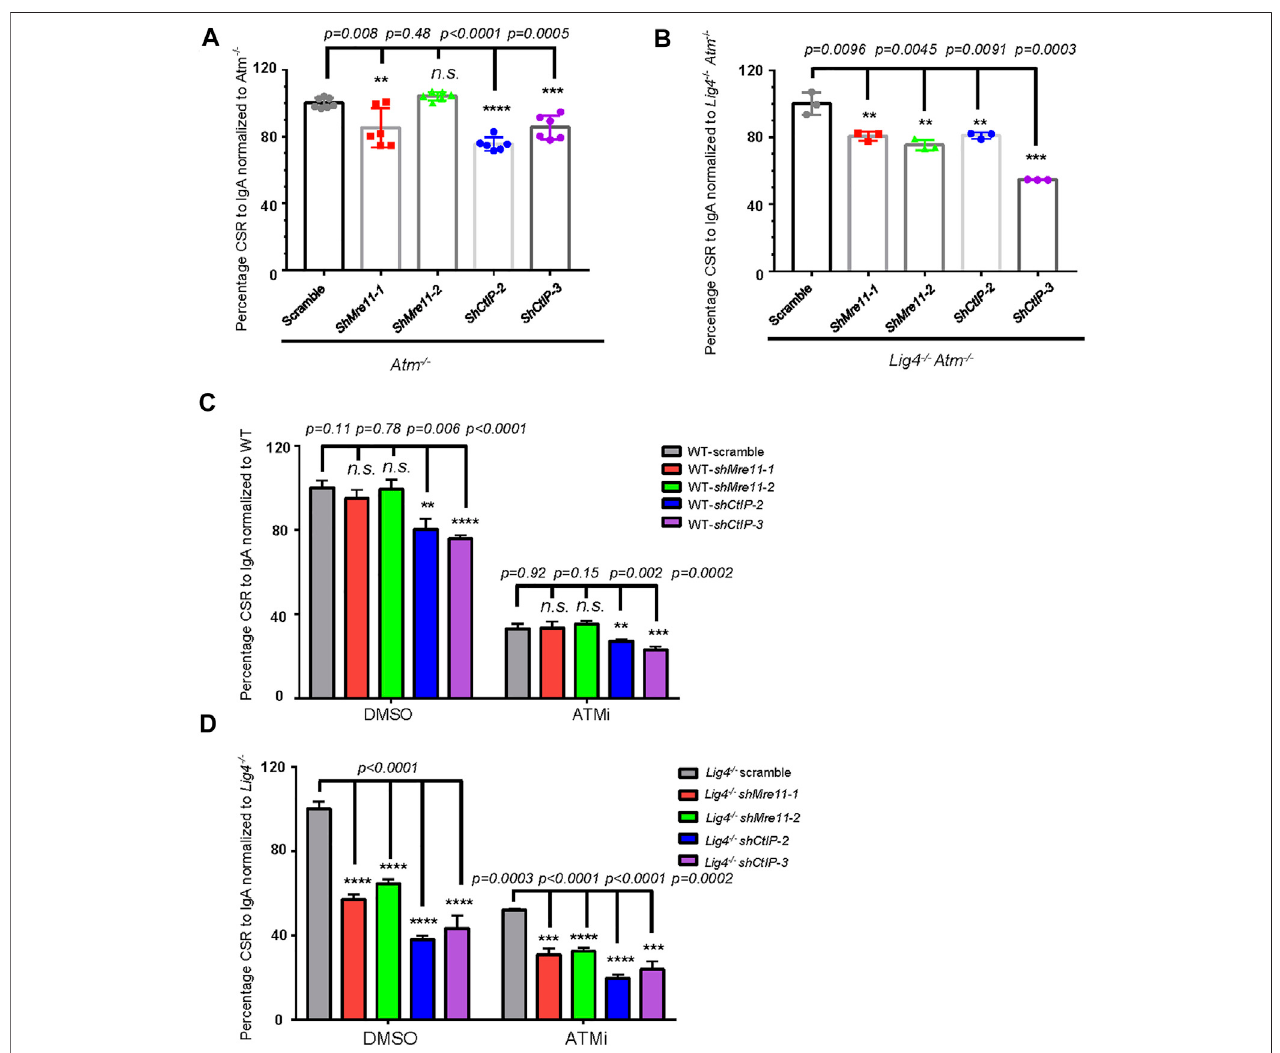
FIGURE5| ATMandMre11/CtIPpromoteA-EJmediatedCSRindependentlyofeachother. (A,B) SilencingMre11/CtIPbydifferentshRNAsfurtherreducedCSR in both Atm − / − cells ( A ) and Lig4 − / − Atm − / − cells ( B ). Data were presented as mean ± SD from six in A , three in B independent experiments (Student ’ s t -test, * p <